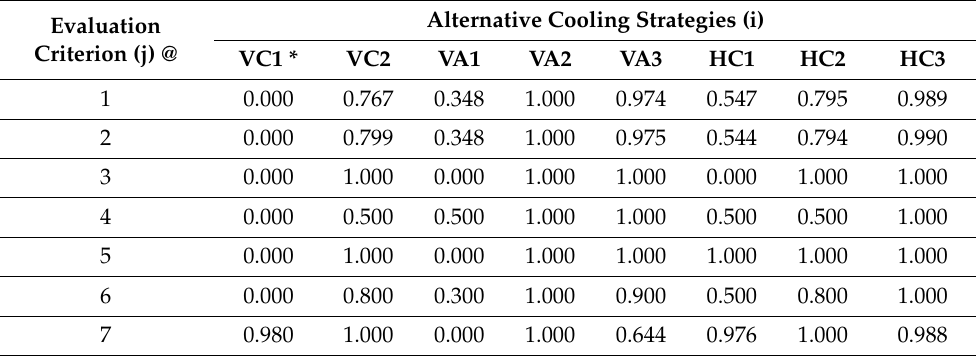
Table 8. Standardized Decision matrix S (cid:48)